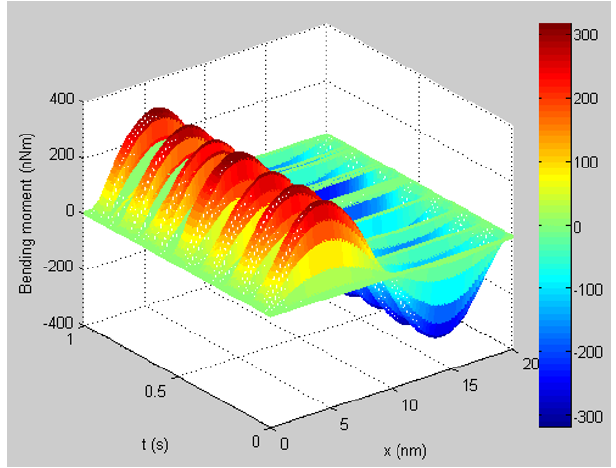
Figure 12. Bending moment Diagram of the SWCNT for mode